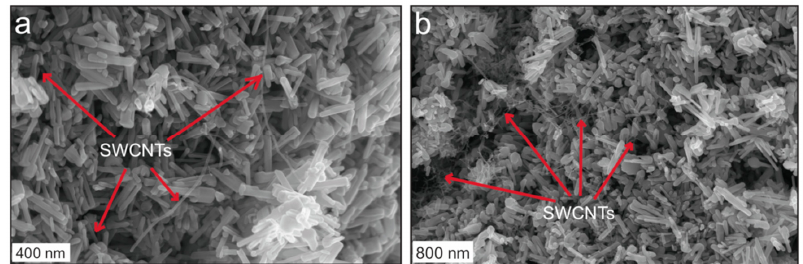
Figure 1. ( a , b ) FE-SEM images of the ZnO–single-walled carbon nanotube (SWCNT) nanocomposites. ZnO nanorods are surrounded by SWCNTs (indicated by the arrows in each image) in the ZnO–SWCNT nanocomposite.